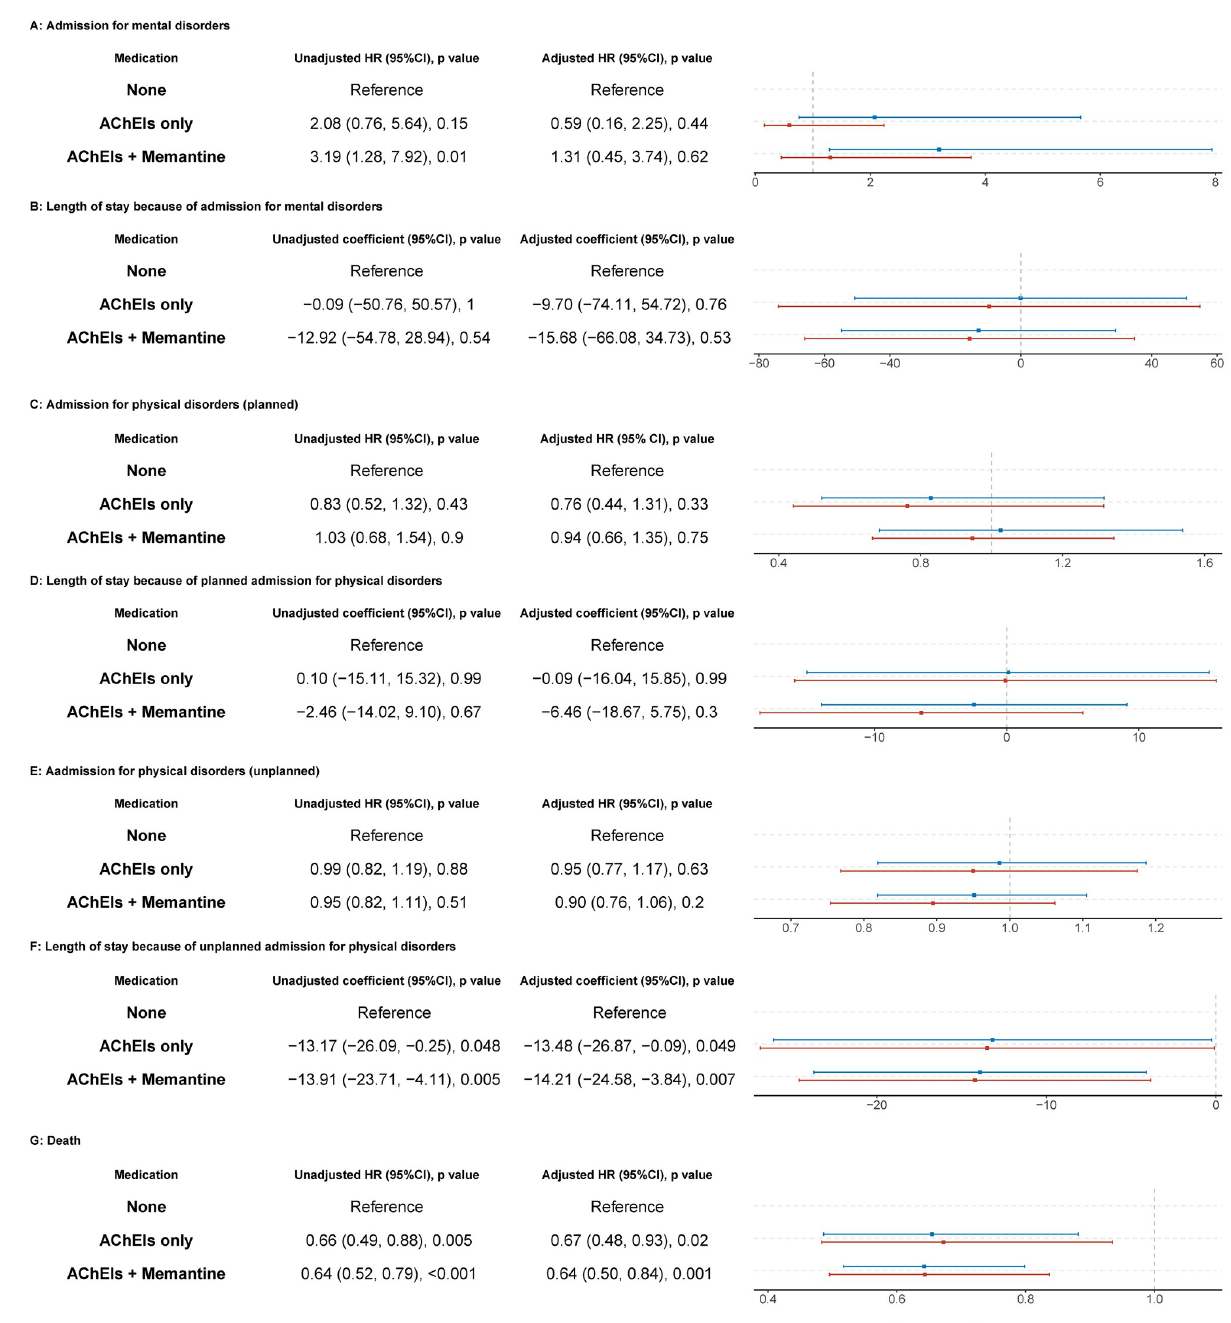
Fig 3. Association of antidementia medication use with risk of admission, length of stay, and risk of death among patients with dementia with Lewy bodies. Hazard ratios (HR), 95% confidence intervals (CI), and p values were estimated from Cox proportional hazards models. Coefficients, 95% confidence intervals (CI), and p values were estimated from linear regression. Adjusted HRs/coefficients were adjusted for age, sex, marital status, ethnicity, socio-economic status (Index of Multiple Deprivation), antipsychotic use, antidepressant use, cognitive status/score, physical comorbidity, anticholinergic burden, and global health performance. The blue lines show the unadjusted HRs/coefficients, the red lines show the adjusted ones, and the grey dotted line shows the cut-off for negative or positive associations (0 for coefficients and 1 for hazard ratios). AChEIs, acetylcholinesterase